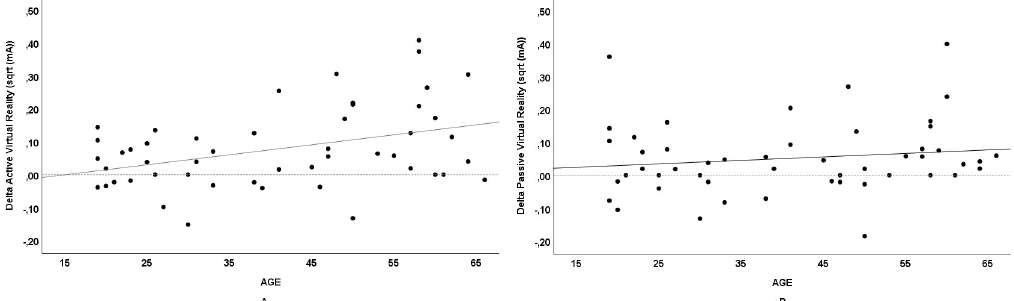
Fig 4. Correlation of age and Virtual Reality in electrical detection thresholds: A. Age and delta Active Virtual Reality, B. Age and delta Passive Virtual Reality.